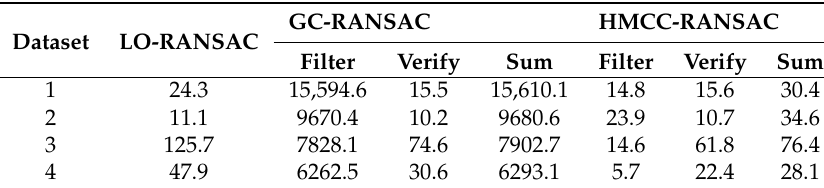
Table 5. Statistical results of geometrical verification (in seconds).